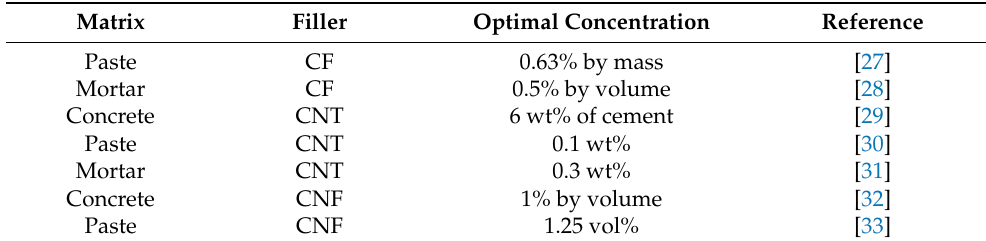
Table 3. Optimal Filler